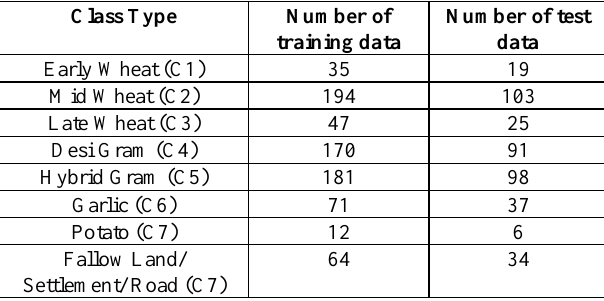
Table 3: Number of ground data used for model training and validation.